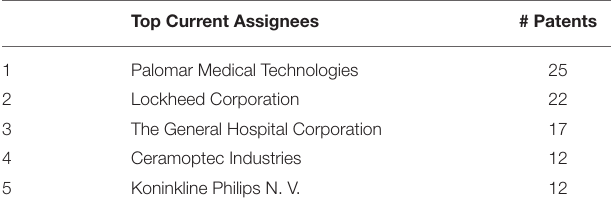
TABLE 6 | Top current assignees in the optical energy-based therapeutic domain.